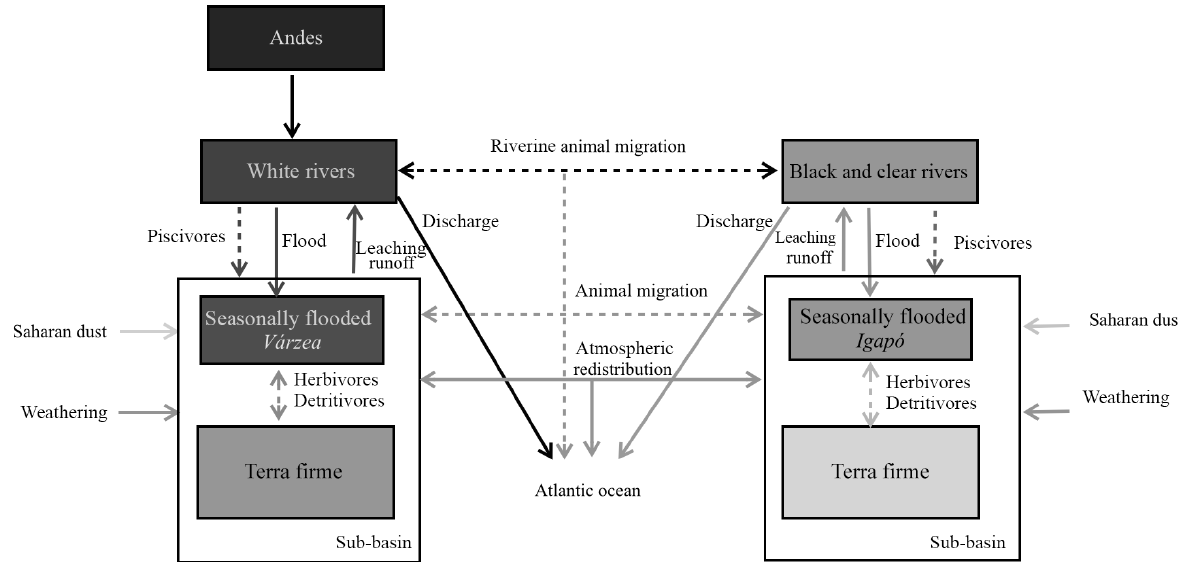
Figure 1. Conceptual diagram of processes transferring P within the Amazon basin’s ecosystems. Conceptual diagram of processes trans- ferring P across ecosystems in the Amazon basin. The boxes represent the major ecoregions of Amazonia and dashed arrows represent animal-driven fluxes and solid arrows represent abiotic-driven fluxes. The grey tone represents the P content of these ecoregions from dark (high P content) to light tones (lower P